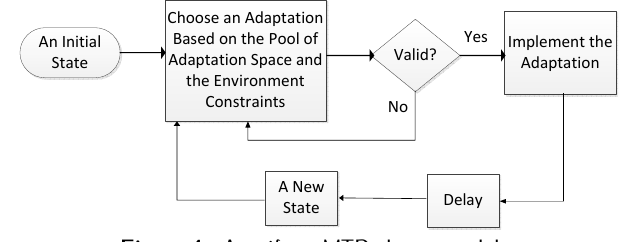
Figure 1. A uniform MTD theory model